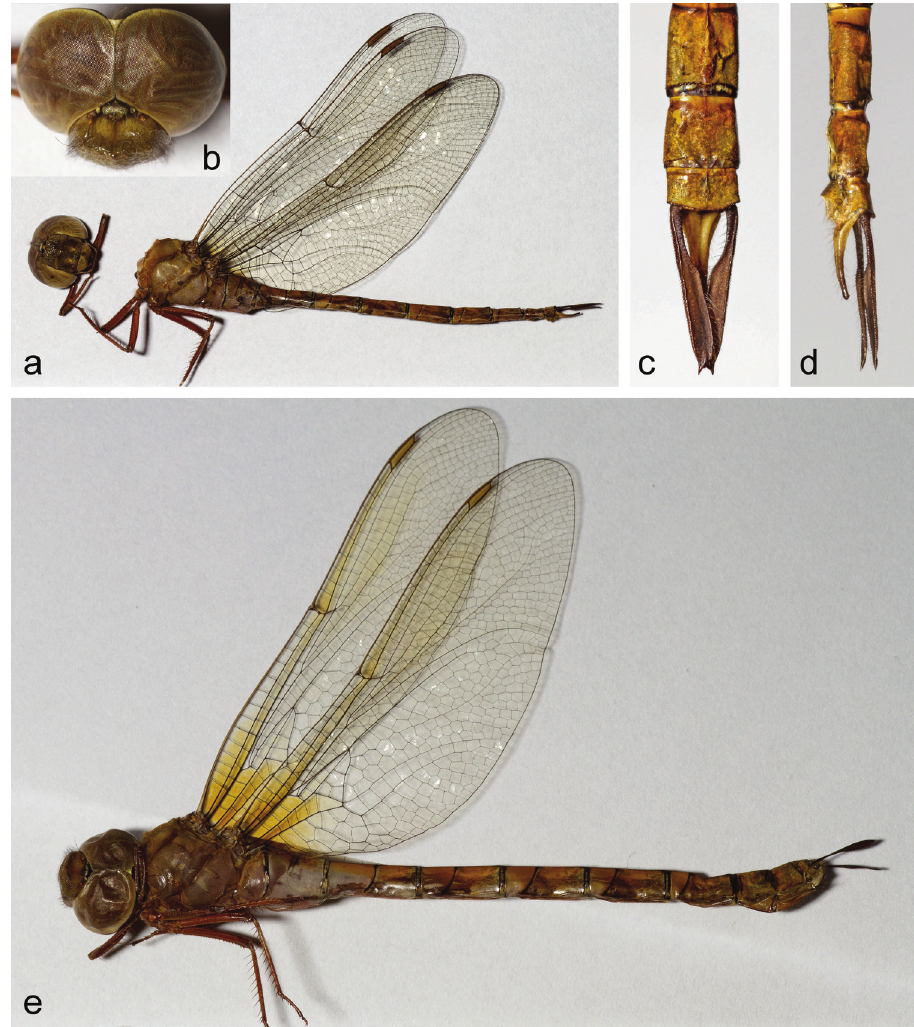
Figure 7. Heliaeschna trinervulata from Chingombe, Zambia: male ( a–d ) and female ( e ), with recog- nisable diagnostic morphological traits such as: relatively open venation ( a, e ) with a low number of cross-veins (e.g. Ax and Mx), the pale frons with a barely marked cross-bar of T-mark ( b, e ), wing bases without dark subcostal rays ( a, e ) but with distinct amber tint in the female ( e ) and shape of male cerci ( c, d ) (phot. B.